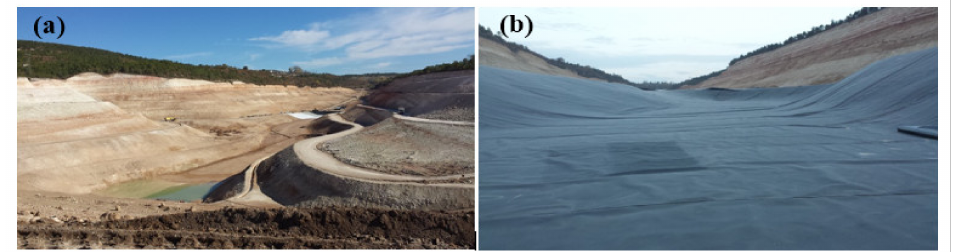
Figure 4. Waste disposal area in Kütahya, Turkey: ( a ) without a barrier material; ( b ) with the barrier material that consisted of a geomembrane-laminated GCL.